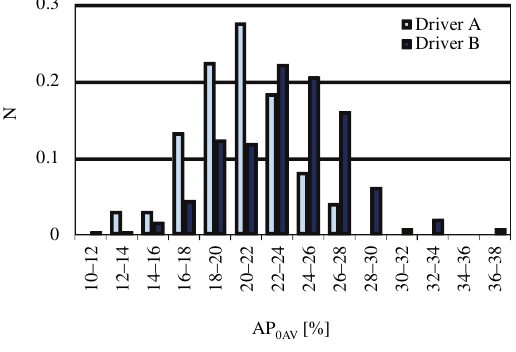
Fig. 26. Average relative position of accelerator pedal, excluding zero position, in urban driving conditions